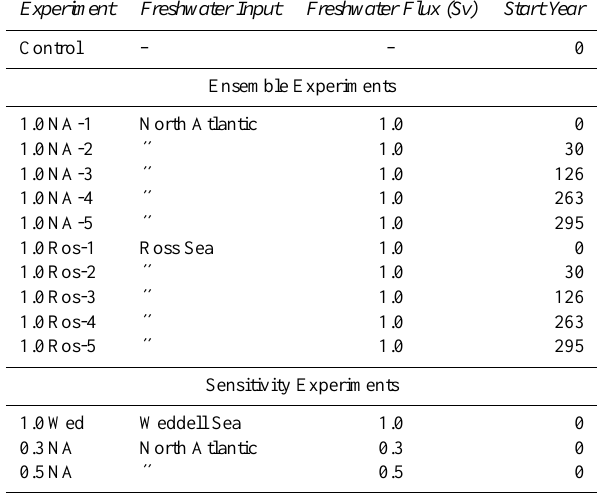
Table 1. List of experiments given together with the region where freshwater is applied and the size of the perturbation. Different starting years for perturbations in the ensemble experiments refer to the date in the Control and are chosen according to the ENSO index in order to account for the effect of natural variability in the system. In addition to the ensemble experiments, three sensitivity simulations have been performed to investigate the effect of a dif- ferent perturbation size and/or freshwater input